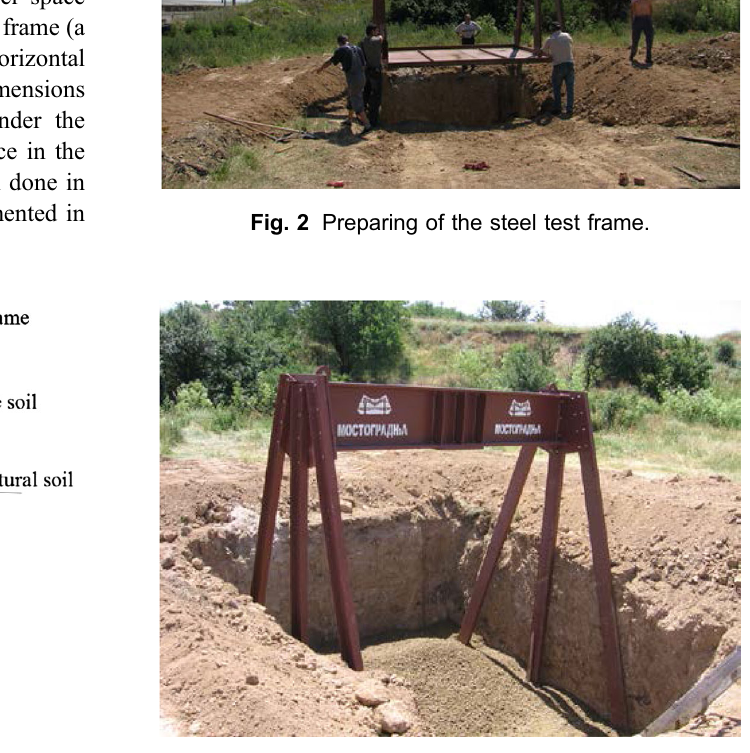
Fig. 3 Test frame in the foundation pit. Fig. 1 Scheme of the experimental setup.